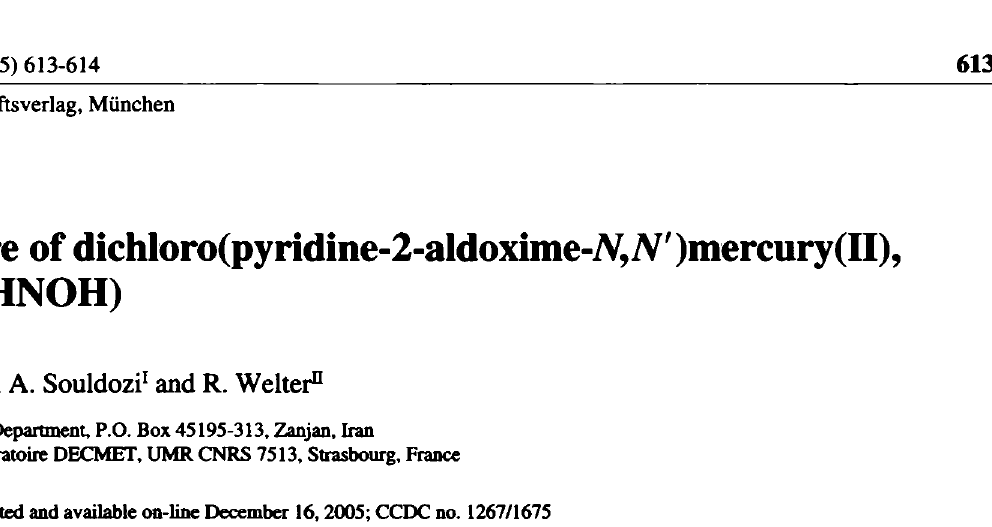
Table 1. Data collection and handling.